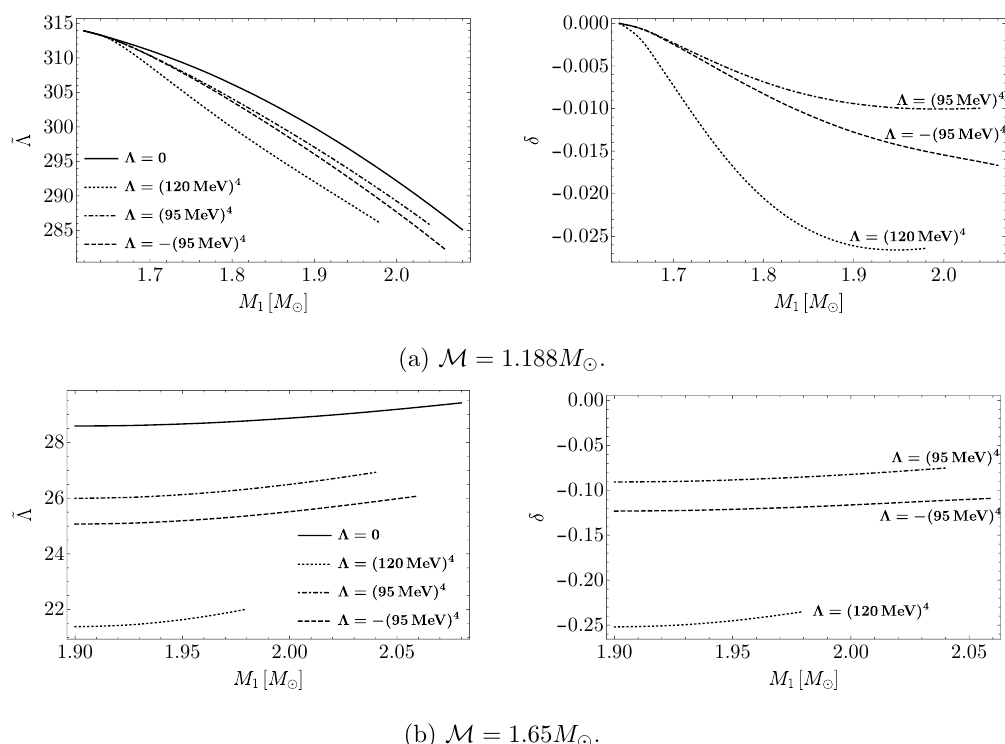
Figure 7. Plot of the deviation of the combined dimensionless tidal deformability as a function of the heavy star mass for the AP4 EoS with di(cid:11)erent values for the chirp mass. Plots on the left show the value of ~(cid:3), while plots on the right show the fractional deviation, (cid:14) . The chirp mass M = 1 : 188 M (cid:12) is the same as the one of GW170817, while M = 1 : 65 M (cid:12) corresponds to a